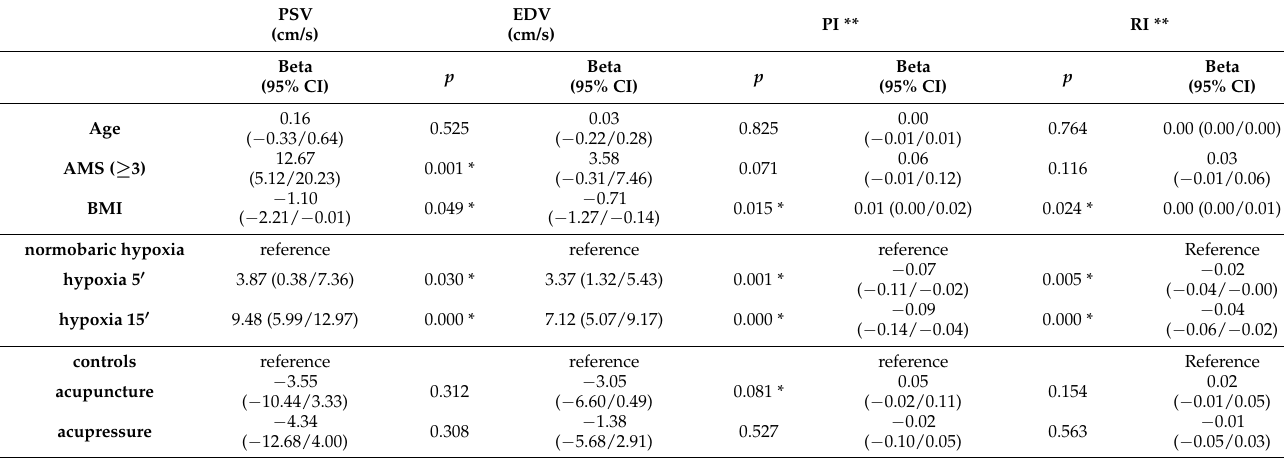
Table 4. Evaluation of blood flow oxyhaemoglobin saturation (SaO 2 ), heart rate (HR), Resistive Index (RI), and Pulsatility Index (PI) in the middle cerebral artery (MCA) in normoxia, in acute normobaric hypoxia for 15 min, in basal conditions, and after PC6 stimulation. Multilevel mixed-effects linear regression adjusted for age, acute mountain sickness (AMS), and body mass index (BMI) multivariate